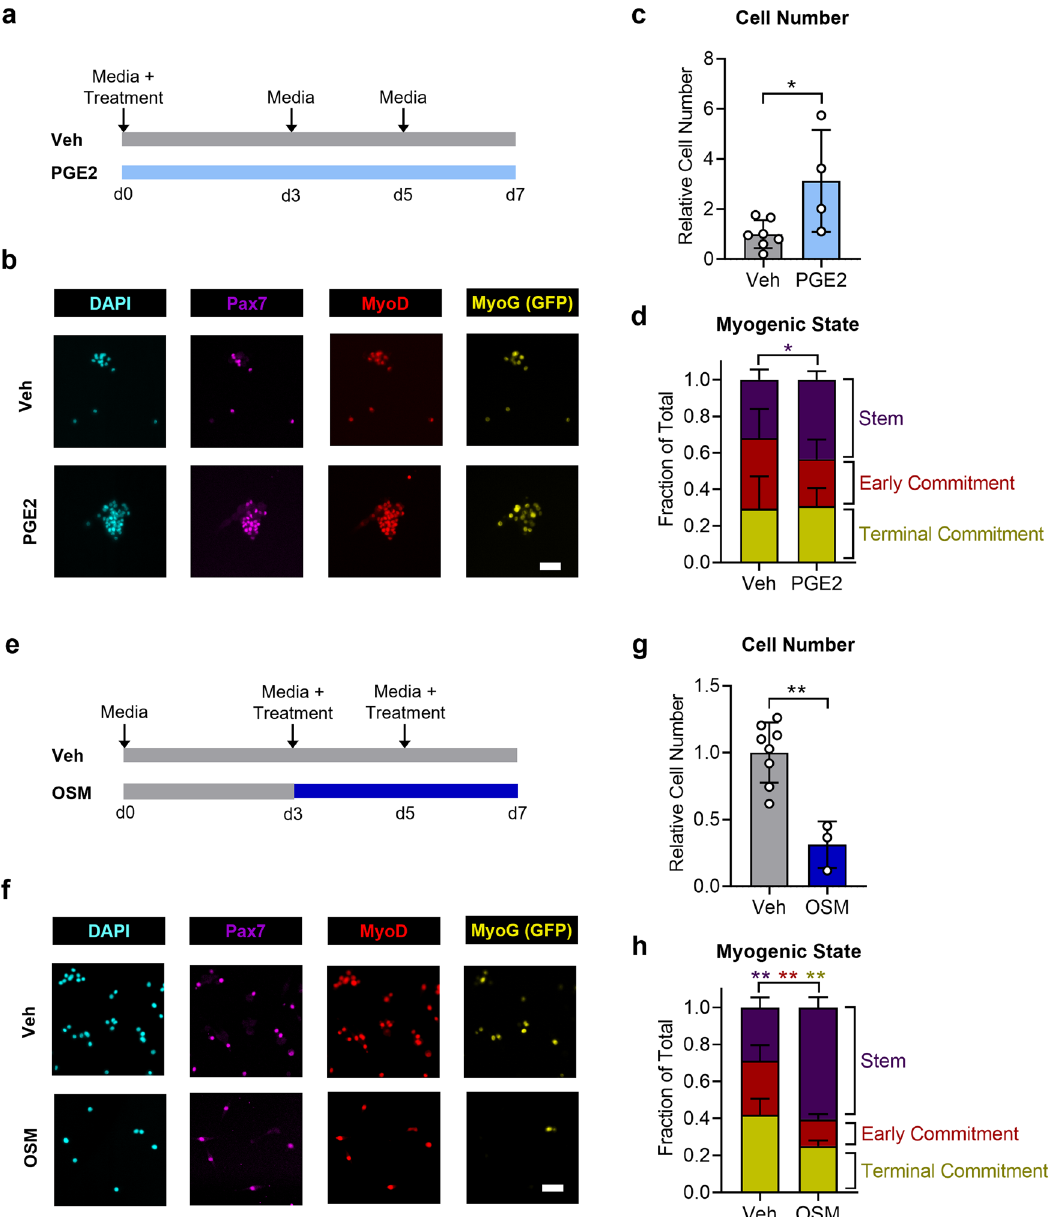
Fig. 1 Population-level analysis of MuSC fate in response to pro-regenerative niche factors. a Schematic depicting the time course of MuSC treatment with PGE2. b Representative immuno fl uorescence images of MuSCs after 7 days of culture, treated with PGE2 or vehicle. c Quanti fi cation of cell number reveals increased proliferation in PGE2-treated MuSCs by day 3 in culture. d Quanti fi cation of myogenic factor expression 7 days after PGE2 treatment reveals expansion of the stem cell pool. e Schematic depicting the time course of MuSC treatment with OSM. f Representative immuno fl uorescence images of MuSCs after 7 days of culture, treated with OSM or vehicle. g Quanti fi cation of cell number reveals decreased proliferation in OSM-treated MuSCs at day 7 in culture. h Quanti fi cation of myogenic factor expression 7 days after OSM treatment reveals a bias toward stemness maintenance and decreased commitment in OSM-treated MuSCs. In ( d and h ), cells that were Pax7 + and MyoG − were considered part of the “ stem ” population, cells that were MyoD + , Pax7 − , and MyoG − were considered part of the “ early commitment ” population, and cells that were Pax7 − and MyoG + were considered part of the “ terminal commitment ” population. * p < 0.05, ** p < 0.01, two-tailed Student ’ s t test. Data in bar graphs are represented as mean ± standard deviation. In ( d and h ), the color of the stars denoted the pairwise comparison performed (stem, early commitment, or terminal commitment). In ( c and d ), n = 7 independent replicates for controls and 4 independent replicates for PGE2 treatment. In ( g and h ), n = 8 independent replicates for controls and 3 independent replicates for OSM treatment. In ( b and f ), scale bars represent 50